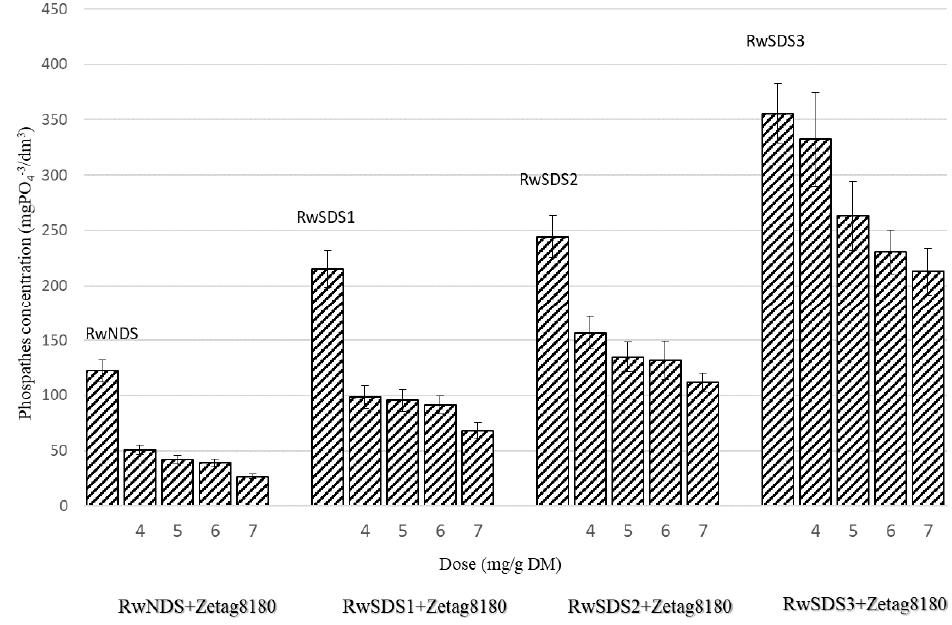
Figure 5. Changes of the phosphate concentration in reject water separated from sludge prepared with Zetag 8180.